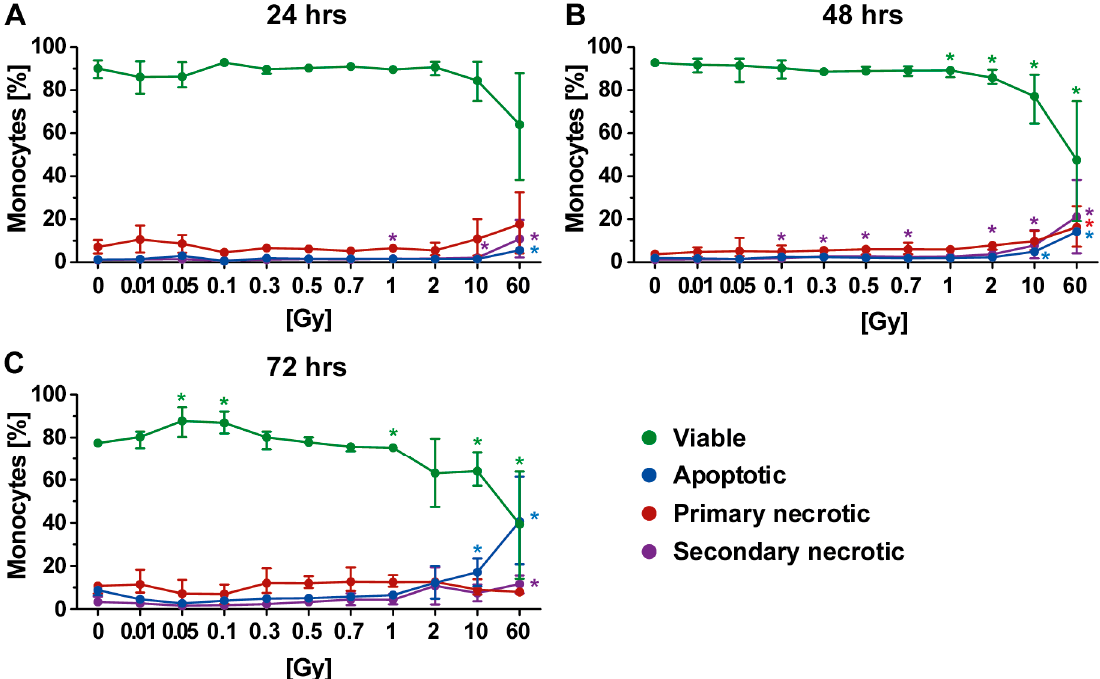
Figure 6. Forms of cell death in monocytes at different time points after irradiation. ( A – C ) Decreased viability of monocytes was only observed following exposure to a high single dose of irradiation. The colored dots represent the percentage distribution of viable (green), apoptotic (blue), primary (red), or secondary necrotic (violet) monocytes as determined by AxPI staining and flow cytometry at ( A ) 24, ( B ) 48, or ( C ) 72 h after irradiation. Each data point represents the median ( ± IQR) from four independent experiments of two different donors. Data points have been connected by lines to improve visual clarity. Statistical analyses were performed against the corresponding non-irradiated control (0 Gy) using the Mann–Whitney U test (* p < 0.05; ** p < 0.01).